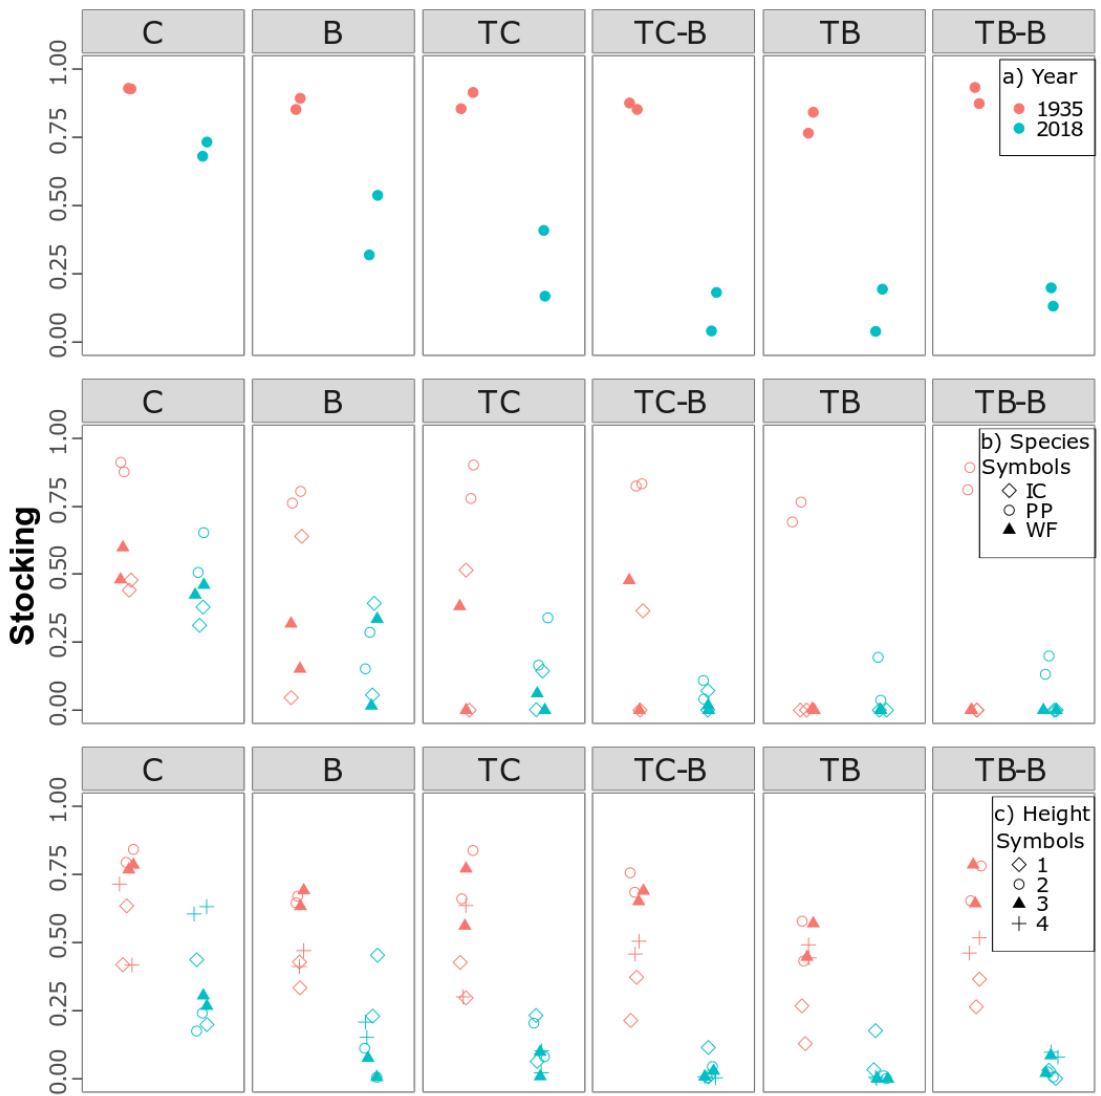
Figure 6. Stocking proportion calculated at 0.0016 ha in 1935 (red) and 2018 (blue) for 12 compartments by ( a ) years, ( b ) species, and ( c ) height class for various management treatments. Height Class 1: 0–0.31 m, Class 2: 0.31–0.91 m, Class 3: 0.91–1.83 m and Class 4: > 1.83 m for seedlings less than 8.89 cm diameter at breast height (dbh). IC: incense-cedar, PP: ponderosa pine, WF: white fir. C: control, B: prescribed fire, TC: combination thinning, TC-B: combination thinning with prescribed fire, TB: thinning from below, TB-B: thinning from below with prescribed fire.